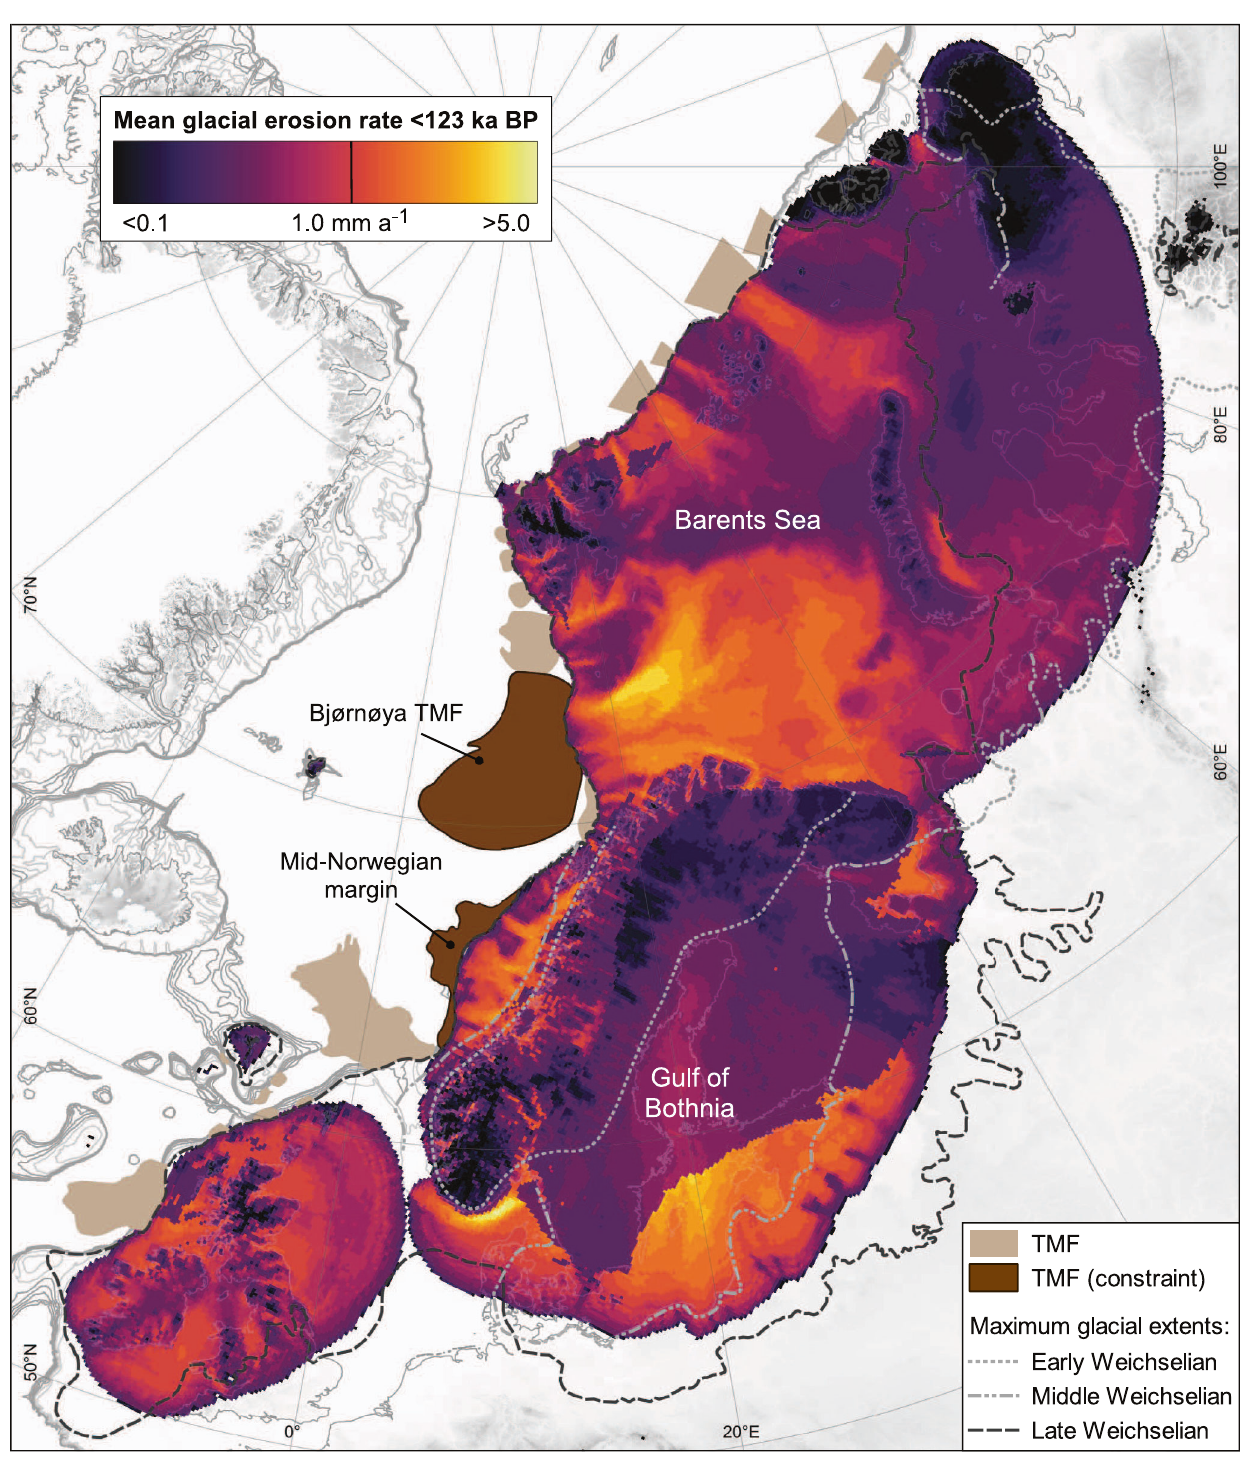
Fig. 3 | The erosional footprint ofthe EIS. Subglacial erosion over the last 123 ka, normalized for ice occupancy. Empirical-based limits of glaciation and the trough mouth fans (TMF) 104,105 used to constrain glacial erosion rates in Platform